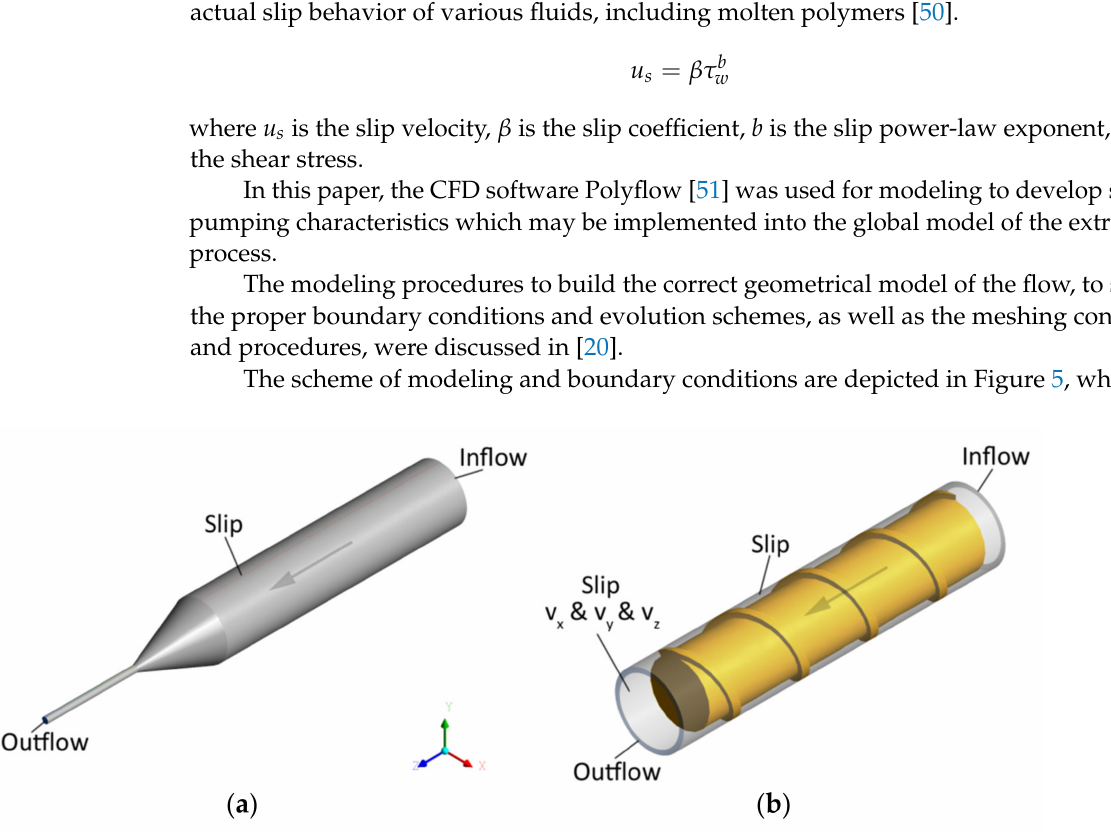
Figure 5. The boundary conditions for flow simulations: ( a ) Die flow, ( b ) screw flow. BC1—Inflow (Q in ) = (Q 0 ), the flow rate Q 0 is imposed at the inlet of the domain, BC2—Outflow, which means that vanishing normal forces and tangential velocities are imposed at the outlet (f n & v s ) = (0, 0), BC3—Slip at the die/barrel wall, i.e., vanishing normal velocity is imposed,